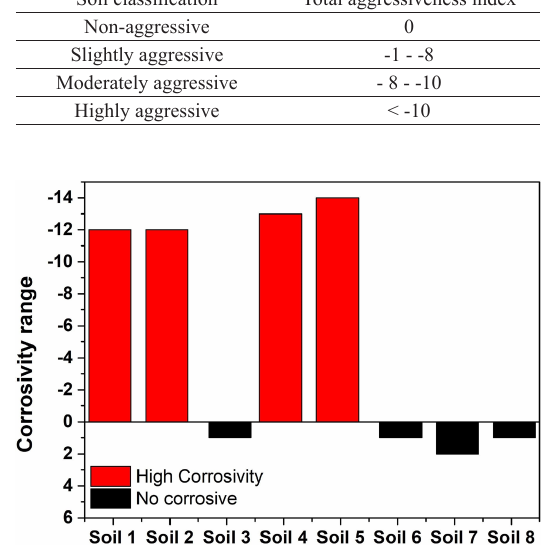
Figure 8. Corrosivity classification of soils in accordance with its physicochemical parameters by suggested index.